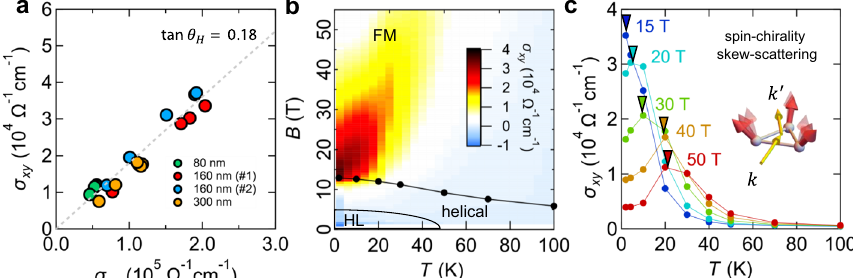
Fig. 2 Characteristics of the AHE observed in MnGe thin fi lm, suggesting a spin-chirality skew-scattering. a Plot of Hall conductivity ( σ xy ) versus conductivity ( σ xx ) for the thickness of t = 80, 160, and 300 nm. The data are taken from the peak positions of the Hall angle below 30 K. The linear relation ( σ xy / σ xx ) appears in a certain B – T region with a large Hall angle of (cid:2) 18 % . b Contour plot of σ xy in the B – T space with the magnetic phase diagram consisting of the hedgehog lattice (HL), helical, and the ferromagnetic (FM) phases. c Constant- B cut of σ xy showing a peak structure at a fi nite temperature. The triangles denote the peak positions, which shifts to a higher temperature at a higher magnetic fi eld. These results are suggestive of the relation to the thermal excitation of the scalar spin chirality (inset in Fig.